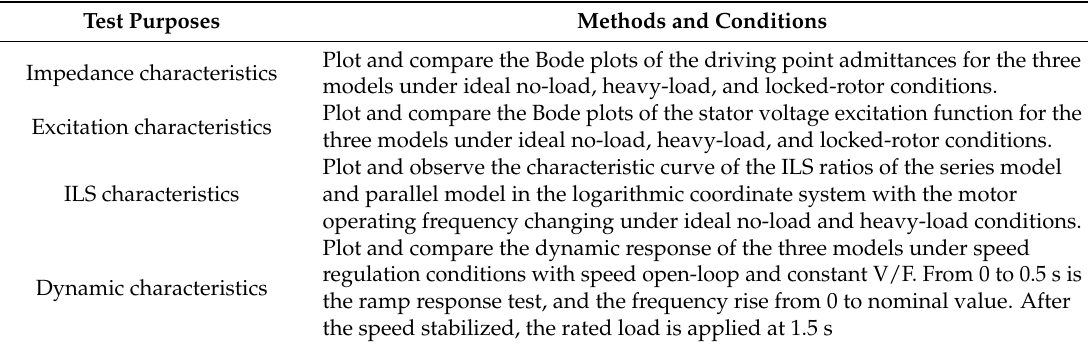
Table 3. Experimental contents and